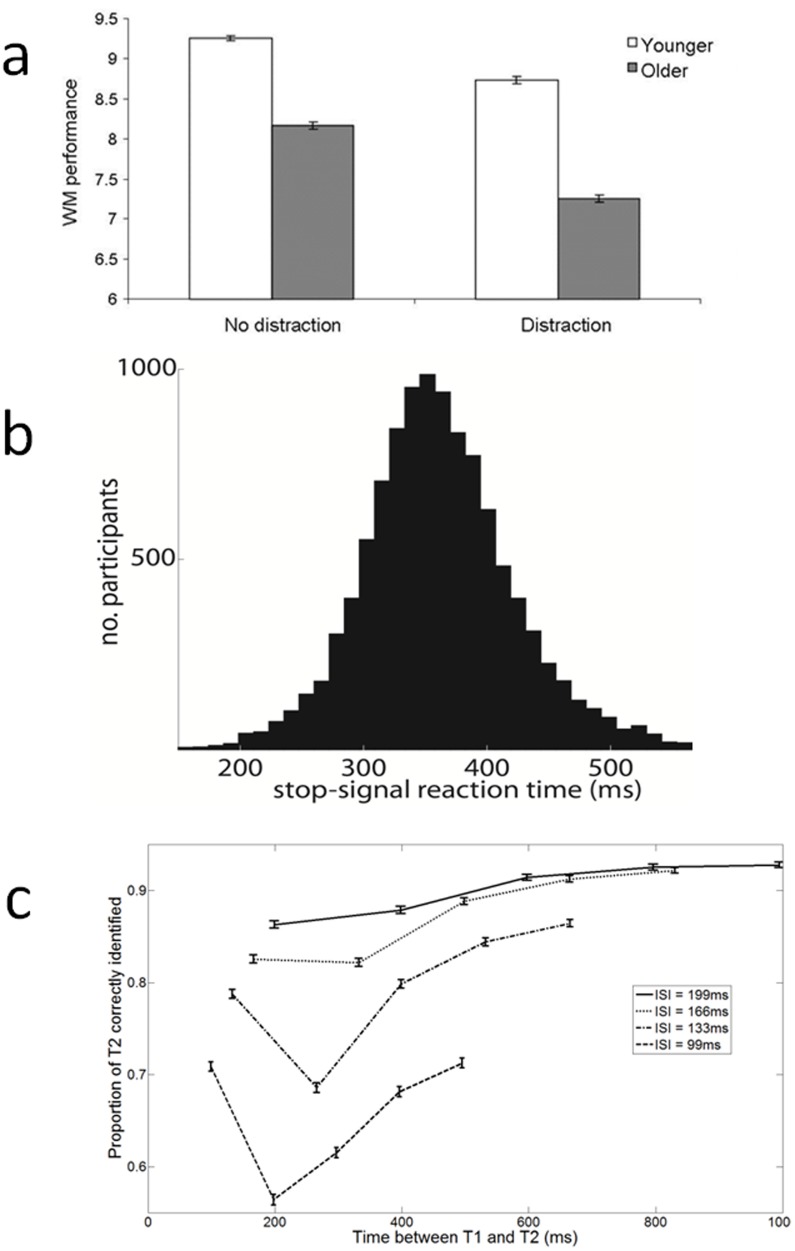
Data from the games in this app. (a) Working memory performance in ‘no distraction’ (remember red circles) and ‘distraction’ (remember red circles and ignore yellow circles) conditions, for younger and older participants.Performance deteriorated with age and distraction, and distraction had a more detrimental effect for older compared to younger adults. (b) Stop-signal reaction time, which measures inhibitory ability, could be estimated from participant's data. (c) Probability of successful identification of T2 in the attentional blink task, for each ISI and lag. T2 recognition was significantly impaired 150–500 ms after T1 presentation, but preserved T2 recognition at lag 1 (‘Lag-1 sparing’) was noted for shorter ISIs.